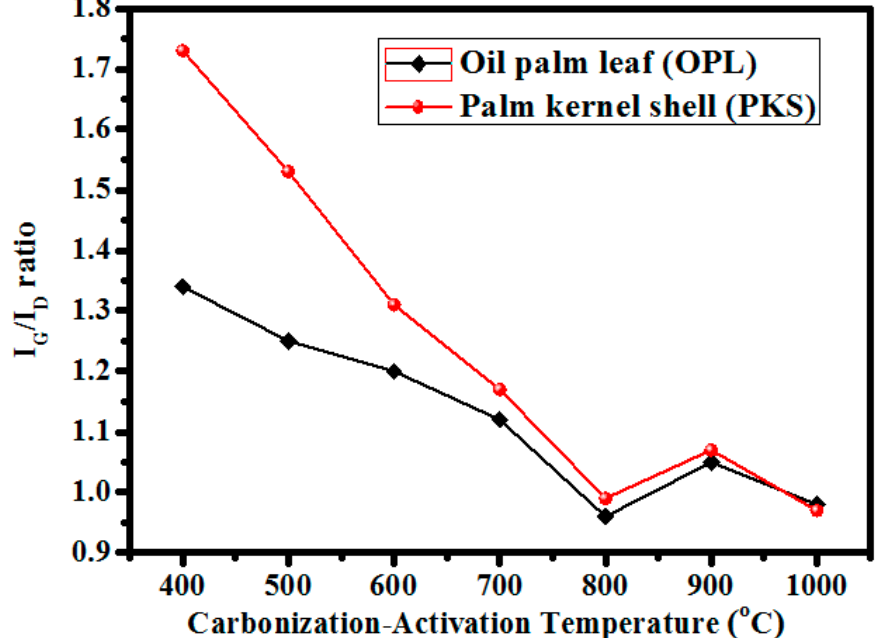
Figure 7. The graphitic trends of the precursors (measured using I G /I D ratio) in relation to the carbonization-activation temperatures.